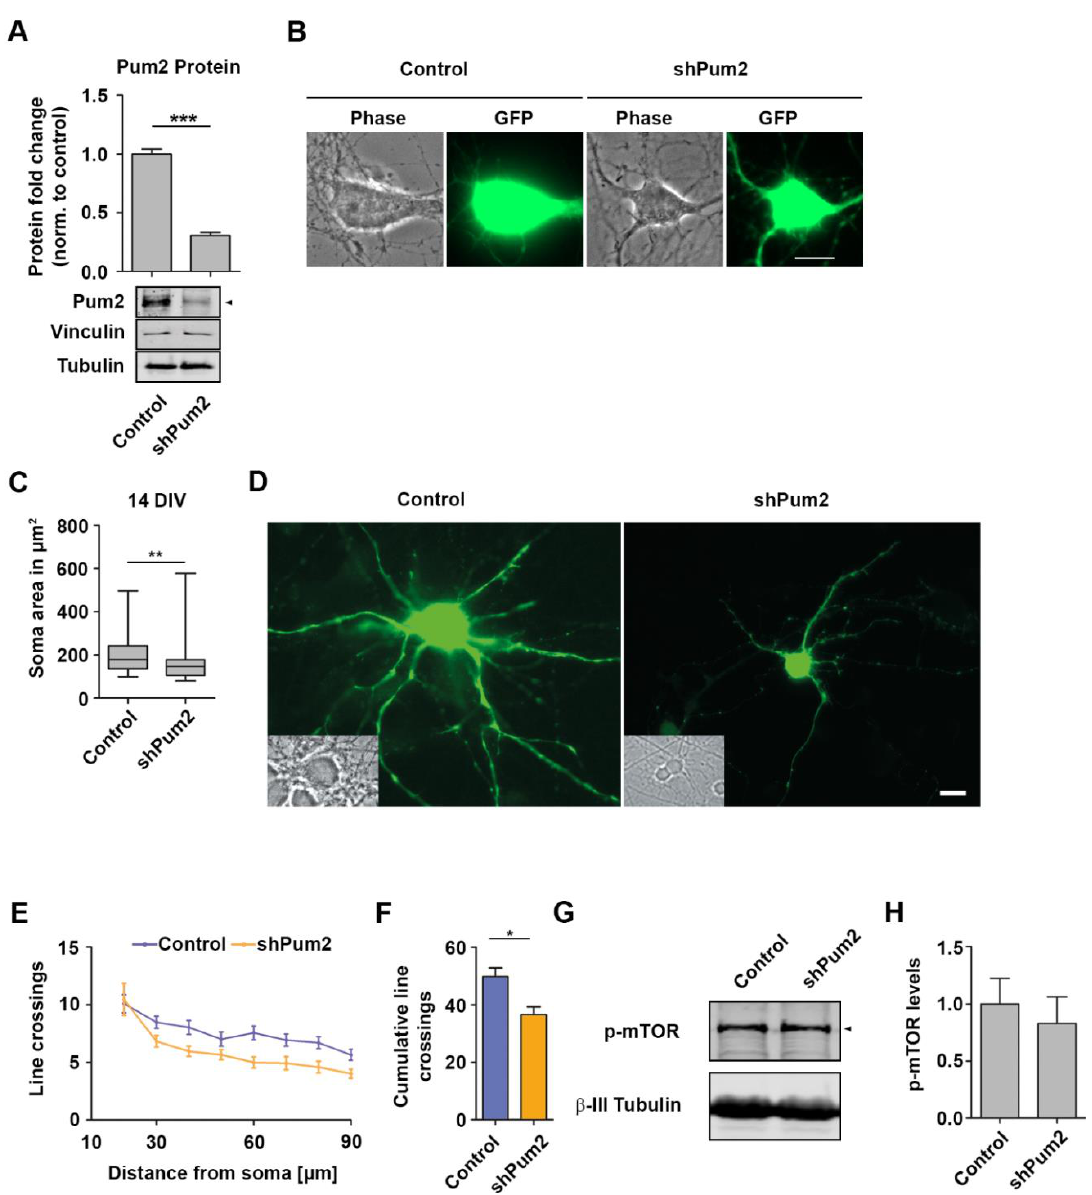
Figure 2. Pum2 promotes growth of mature neurons. ( A ) Representative immunoblot against Pum2 from shControl and shPum2 transduced cortical neurons (14 DIV) and quantification normalized to Vinculin and β -III Tubulin. ( B , C ) Representative phase and fluorescence image ( B ) and quantified soma area ( C ) of shControl and shPum2 transfected mature cortical neurons (14 DIV, >38 cells were measured for each condition, n > 4 cultures). ( D – F ) Representative microscopy images ( D ) and Sholl analysis ( E , F ) of shControl and shPum2 transfected cortical neurons. ( G , H ) Representative immunoblot against phospho-mTOR (Ser2448) ( D ) and quantification from control and shPum2 transduced neuronal lysates ( E ). β -III tubulin was used as loading control. Arrow heads indicate the respective proteins. p -values were calculated using Mann–Whitney test ( C ) or unpaired Student’s t -test ( A , F ). * p < 0.05, ** p < 0.01, *** p < 0.001, Scale bar: 10 µ